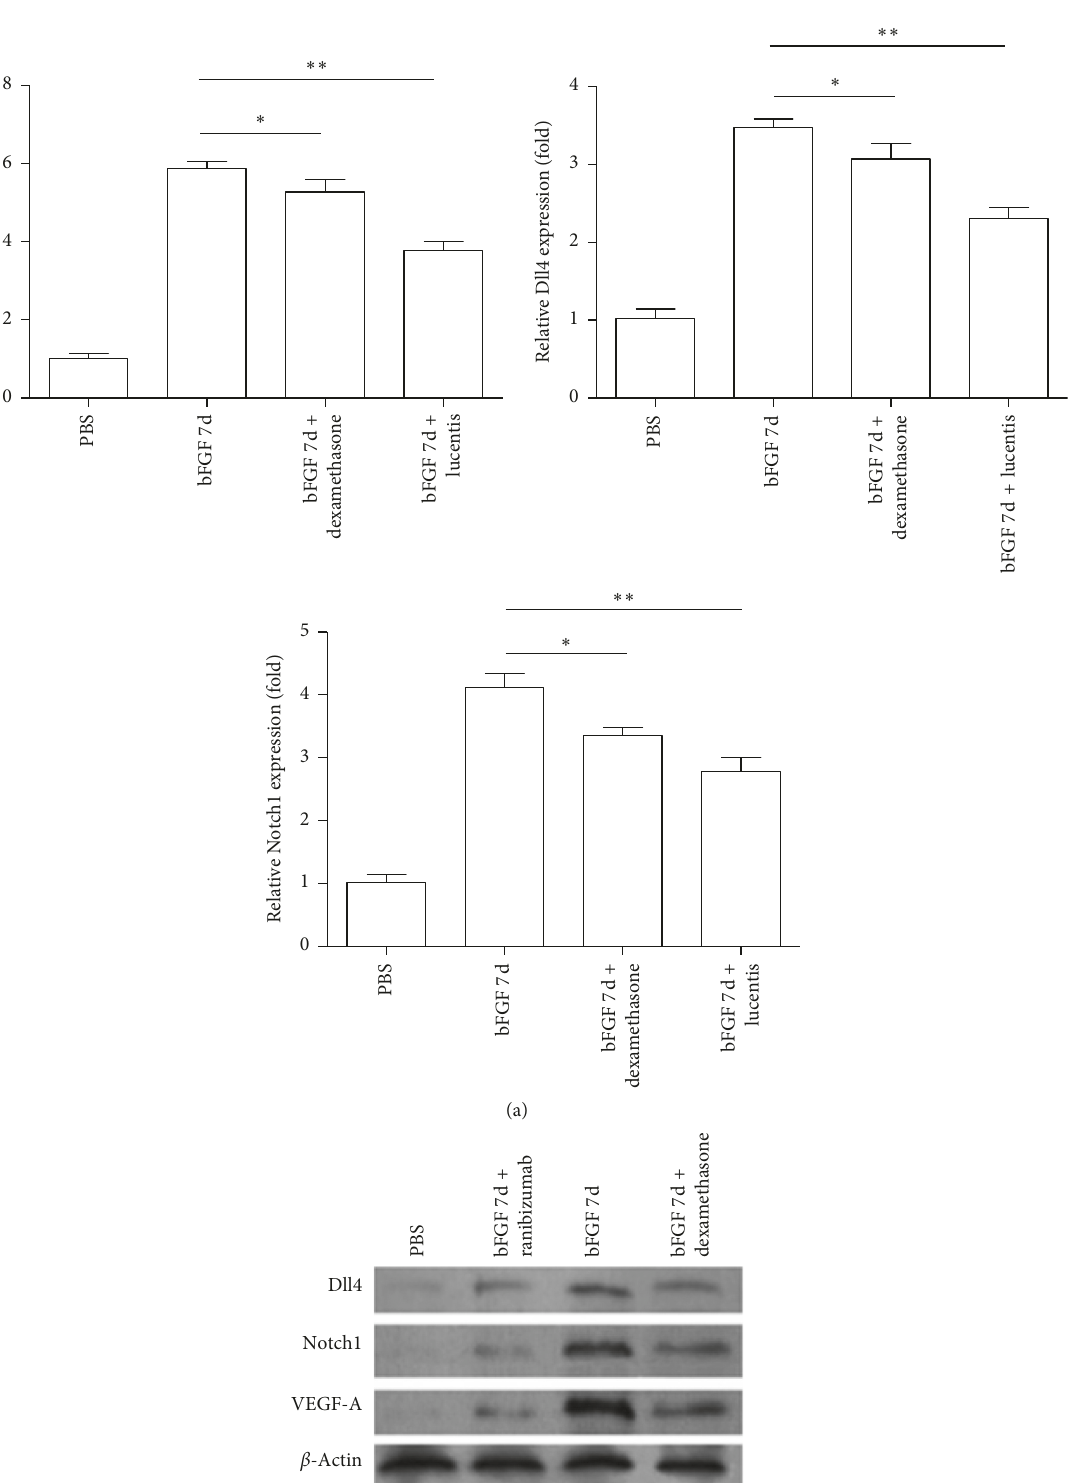
Figure 4: Relative expression of VEGF-A, Notch1, and Dll4 mRNA in the treatment group. (a) Dexamethasone and ranibizumab inhibited the relative expression of VEGF-A, Notch1, and Dll4 mRNA ( n � 4–6). ∗ P < 0 . 05; ∗∗ P < 0 . 01. (b) Representative western blot for VEGF-A, North1, and Dll4 in the treatment